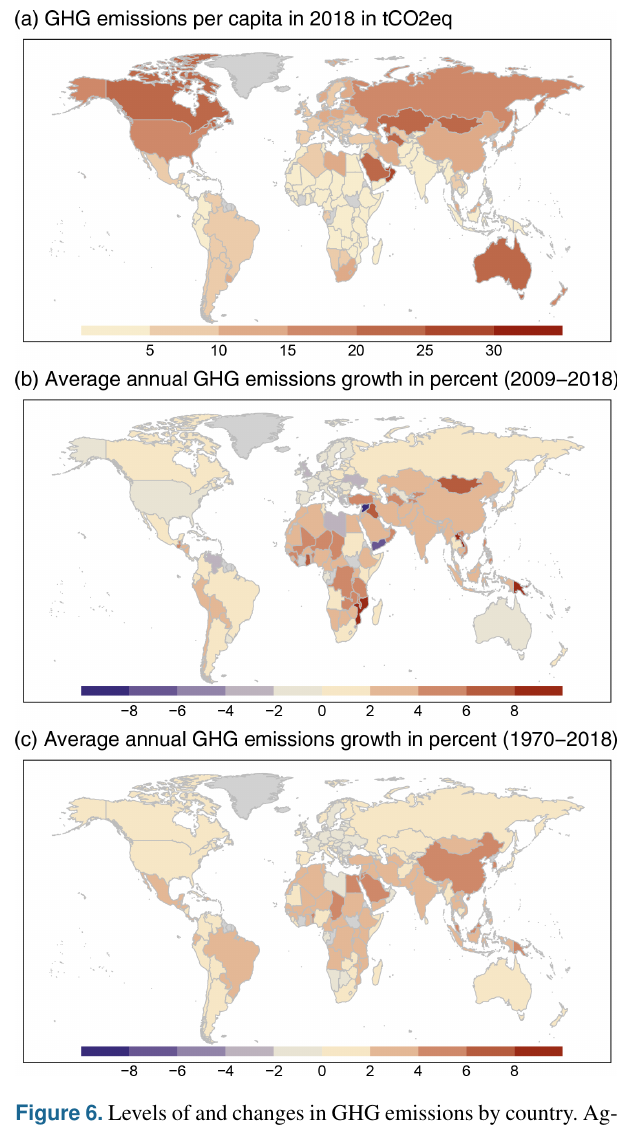
Figure 6. Levels of and changes in GHG emissions by country. Ag- gregate GHG emissions are reported in GtCO 2 eq . based on global warming potentials with a 100-year time horizon (GWP-100) from IPCC AR6 (Forster et al., 2021). Panel (a) shows per capita GHG emissions levels (tCO 2 eq . yr − 1 ) for the year 2018 using UN popu- lation data for normalization (World Bank, 2021). Panel (b) shows average annual changes (in %) in GHG emissions by countries for 2009–2018. Panel (c) shows average annual changes (in %) in GHG emissions by countries for 1970–2018. Note that this excludes CO 2 - LULUCF, as there is currently low confidence in national-level es-